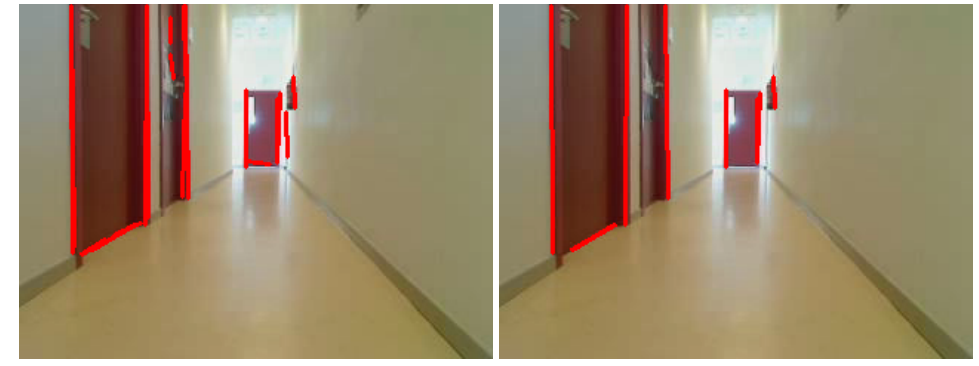
Figure 9. Image analysis before merging (left) and after merging